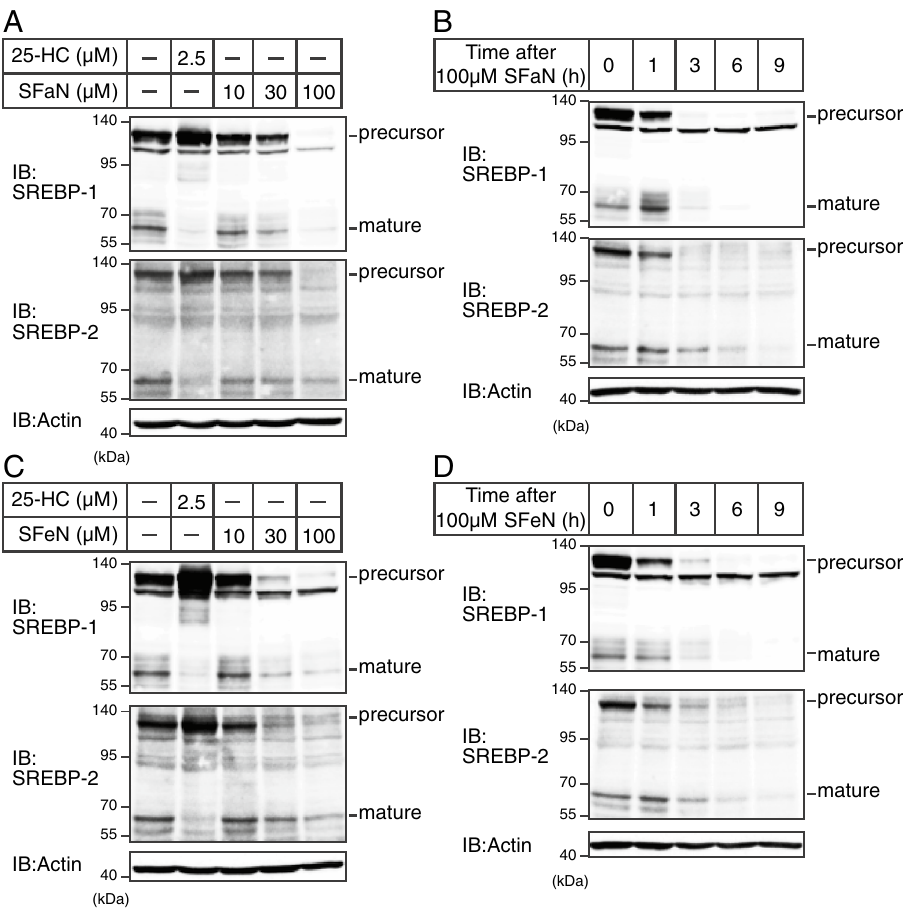
Figure 2. SFaN reduces SREBP precursor and mature form protein levels. ( A , C ) Huh-7 cells were sterol- depleted by incubation in medium D for 16 h. The cells were then shifted into medium D in the presence of the vehicle, 1 μg/ml 25-HC, or the indicated concentrations of SFaN ( A ) or SFeN ( C ). After incubation for 3 h, whole-cell extracts underwent immunoblotting (IB) with anti-SREBP-1 (2A4), anti-SREBP-2, or anti-β-actin antibodies. ( B , D ) Huh-7 cells were sterol-depleted by incubation in medium D for 16 h. The cells were then shifted into medium D in the presence of 100 μM SFaN ( B ) or SFeN ( D ). After incubation for the indicated periods, whole-cell extracts underwent immunoblotting (IB) with anti-SREBP-1 (2A4), anti-SREBP-2, or anti-β- actin antibodies. Full-length images are presented in Supplementary Fig.